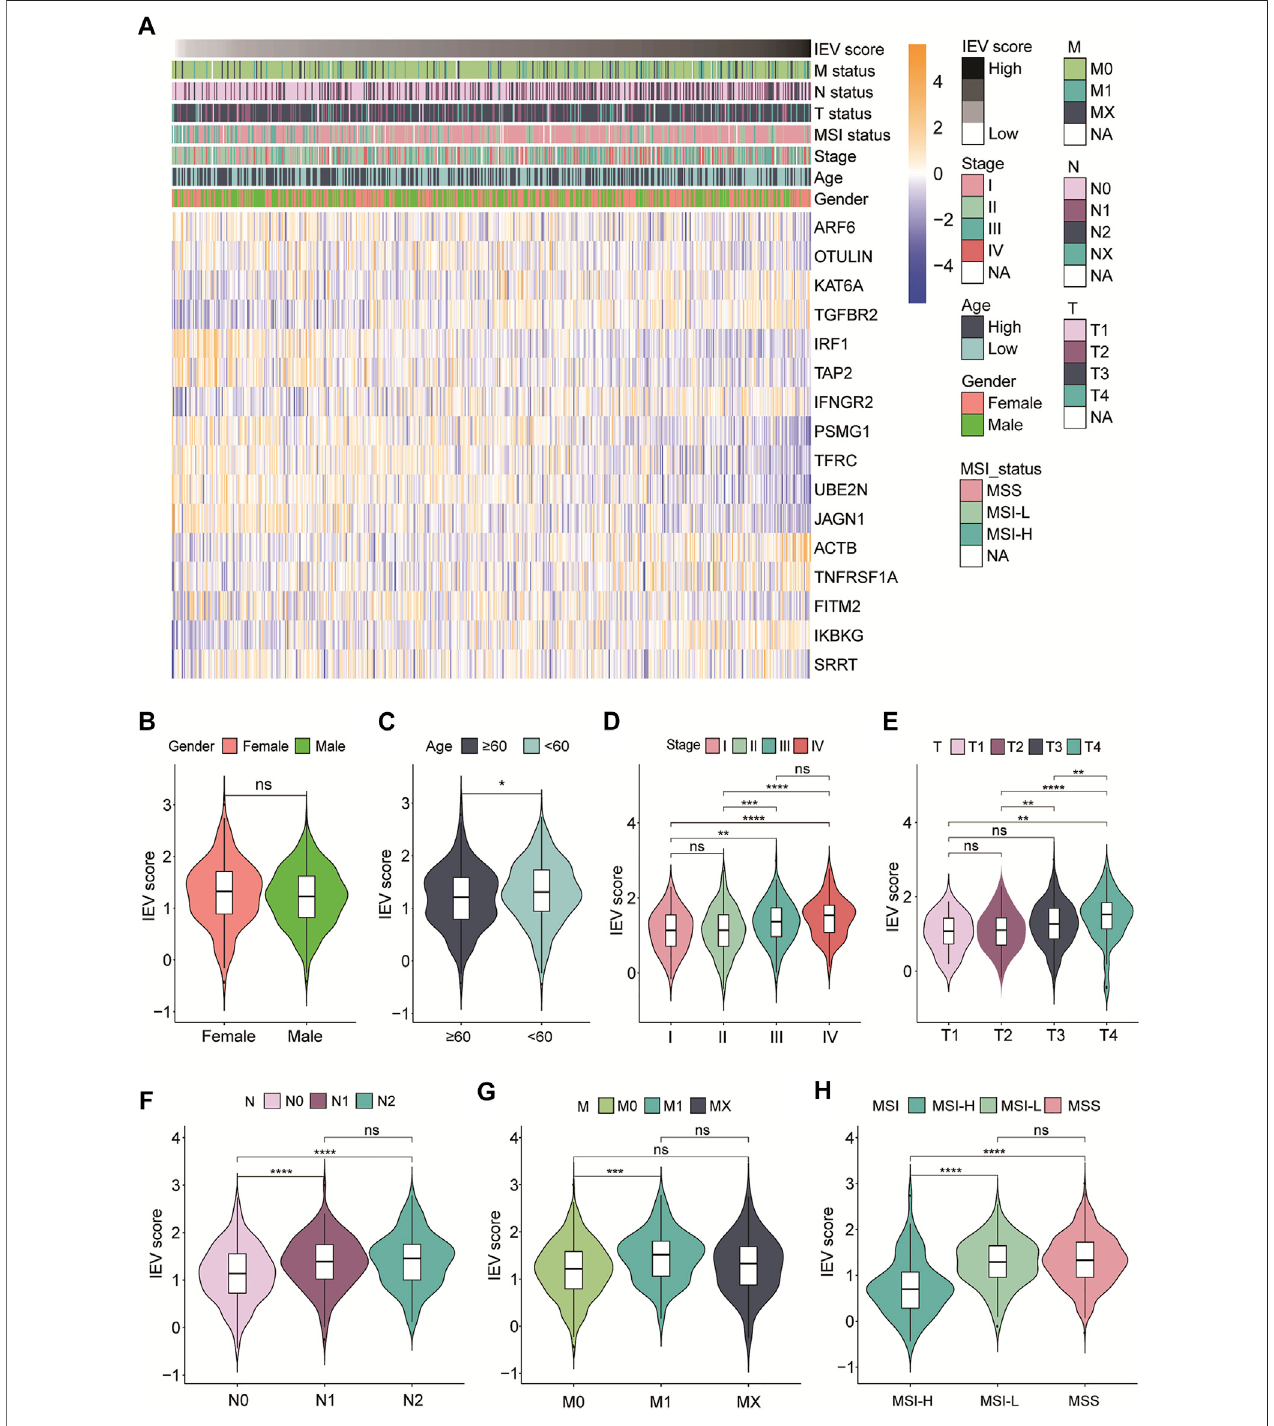
FIGURE4| Immuneevasion-relatedgenessignature (IEVSig)wascorrelatedwithclinicopathological features ofCCpatients. (A) heatmapoftheIEVSig consisting of 16 immune evasion-related genes ordered by the risk scores and its association with clinicopathological features including TNM status, MSI status, stage, age, and gender. (B – H) theviolinplotrepresentationofthecorrelationsoftheIEVSigandgender (B) ,age (C) ,stage (D) ,Tstatus (E) ,Nstatus (F) ,Mstatus (G) ,andMSIstatus (H) .